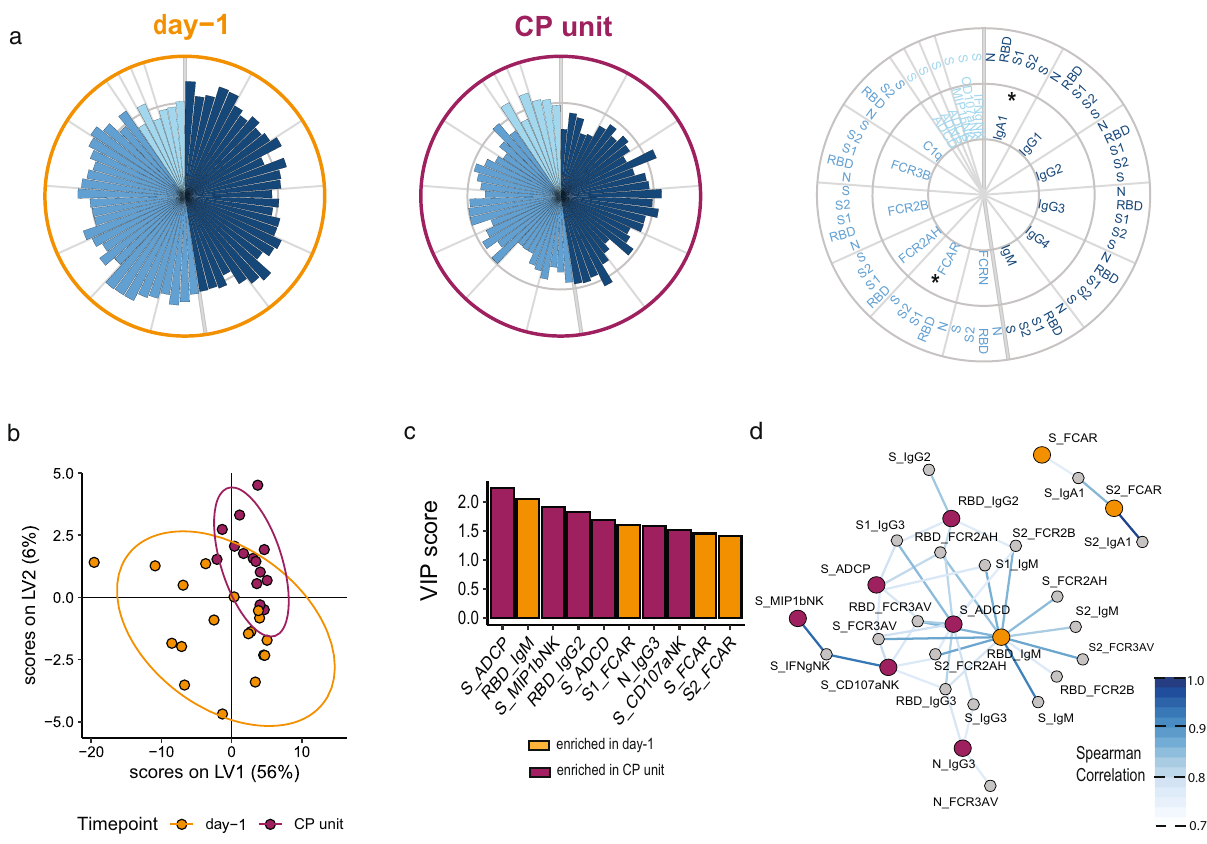
Fig. 2 Functional antibodies were enriched in convalescent plasma. CP recipients and matched CP units were pro fi led for SARS-CoV-2-speci fi c antibody responses. a The polar plots depict the mean percentiles of SARS-CoV-2-speci fi c antibody features within the day − 1 ( n = 18) and CP unit ( n = 14) groups for the antigens N, RBD, S1, S2, and S. Each wedge represents a SARS-CoV-2 antibody feature, and the size of the wedge indicates the magnitude of the value. The colors represent the feature group: dark blue — antibody isotypes and subclasses; blue — Fc-receptor binding levels; light blue — antibody- dependent functions. An asterisk indicates a global p -value obtained by non-parametric combination (two-sided Mann – Whitney U test p -values for partial tests within each feature type, and Fisher ’ s method for combination, * p < 0.05). Partial least squares discriminant analysis (PLS-DA) was applied to identify features distinguishing convalescent from day − 1 severe COVID-19 patients. b PLS-DA scores plot for the fi rst two latent variables. Each dot is one sample, and the ellipses indicate 95% con fi dence regions assuming a multivariate t -distribution. The model achieved an average cross-validation accuracy of 72%. c Variable importance in projection (VIP) score plot showing the top 10 important antibody features out of the 81 antibody features used to construct the PLS-DA model. The color of the bar indicates in which group the feature is enriched, i.e., has a higher median value. d Co-correlation network of features from the PLS-DA model in b with the top 10 VIP scores. The color of the nodes indicates whether the feature was enriched in donor CP vs. day − 1 severe COVID-19 patients. Nodes that were not top features were colored gray. Nodes enriched in day − 1 were colored in orange and nodes enriched in donor CP were colored in maroon. Edges were included if Spearman correlation was statistically signi fi cant after Benjamin – Hochberg correction of a two-sided p < 0.05 and the value of R coef fi cient was above 0.75. The strength of the correlation was represented by the color of the edge with higher correlation coef fi cients represented by darker blue. Source data are provided as a Source Data fi